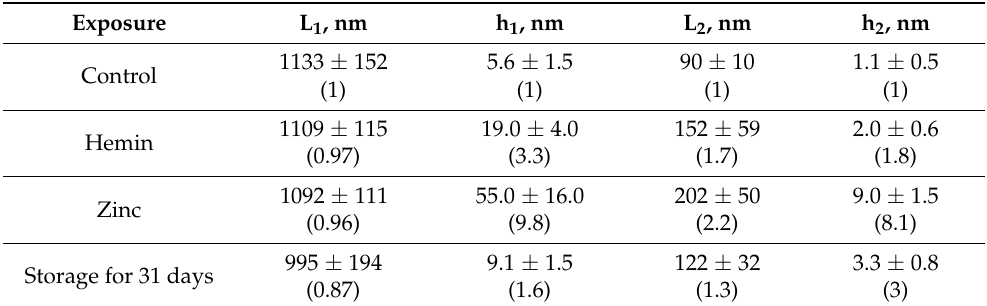
Table 1. Cell membrane parameters (L 1 , h 1 ; L 2 , h 2 ) of controls and cells exposed to hemin and zinc, and after 31 days of